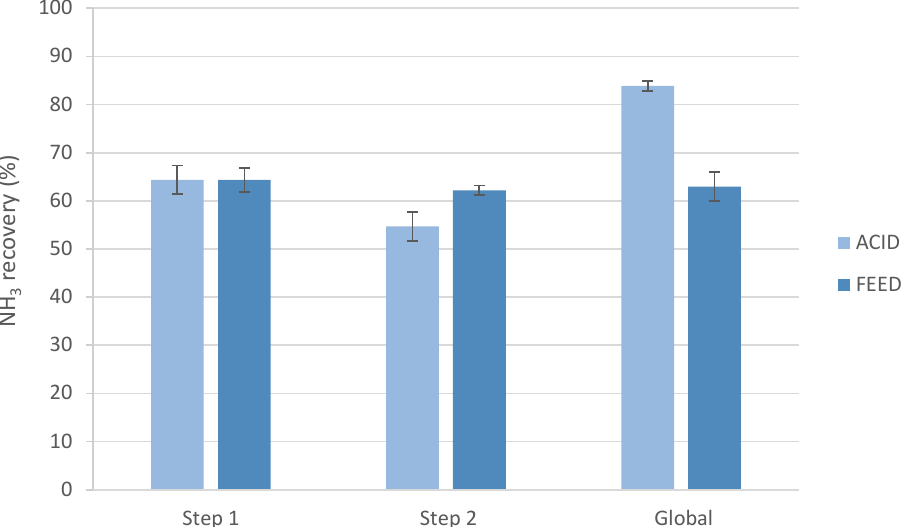
Figure 2. Ammonia recovery after each step, and the global results changing the acid or the feed solution between steps.